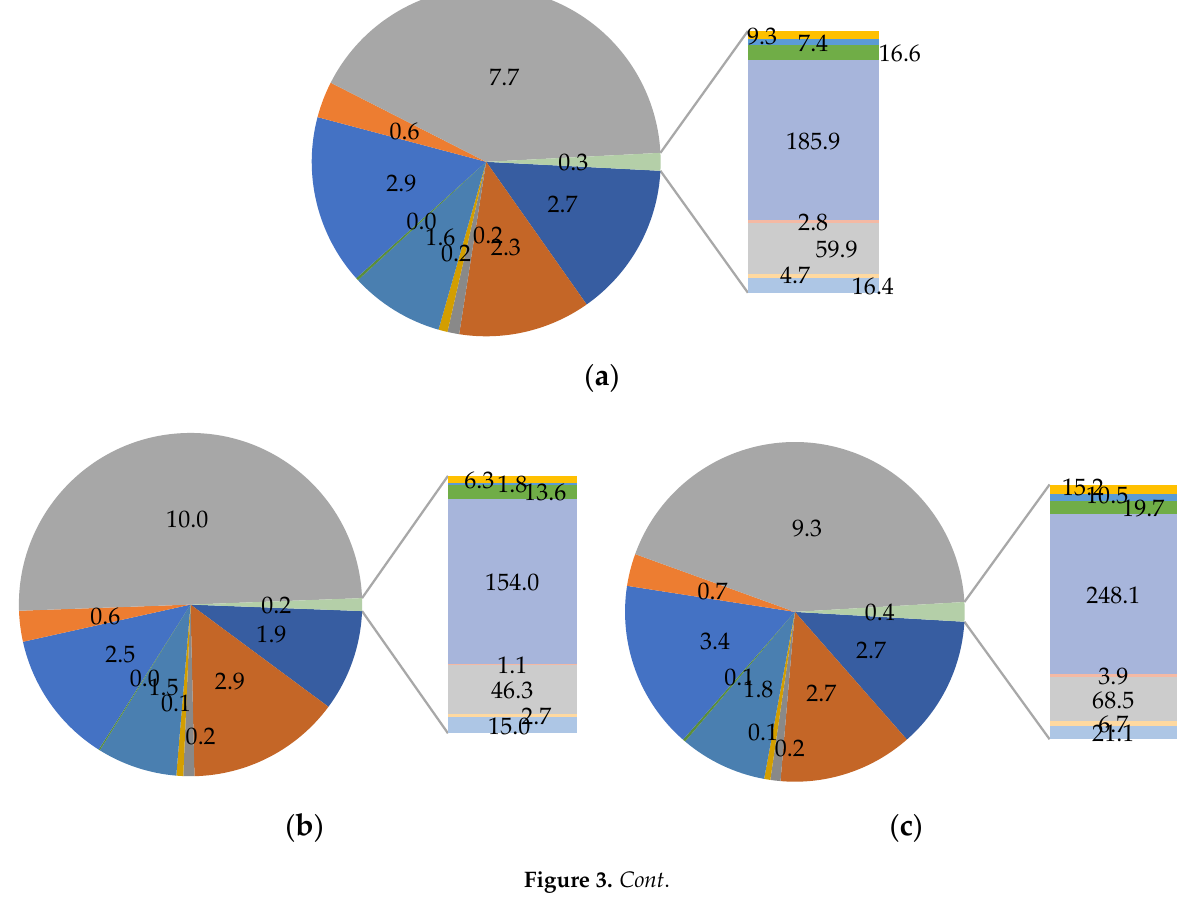
( e ) Figure 3. Pie-chart showing the mean concentrations of different components of PM2.5, obtained using hourly data for Ulsan. ( a ) Annual mean; ( b ) mean for winter months; ( c ) mean for spring months; ( d ) mean for summer months; ( e ) mean for fall months. (Units: µg/m 3 for pie-chart, ng/m 3 for vertical chart) (see Table S2 for more